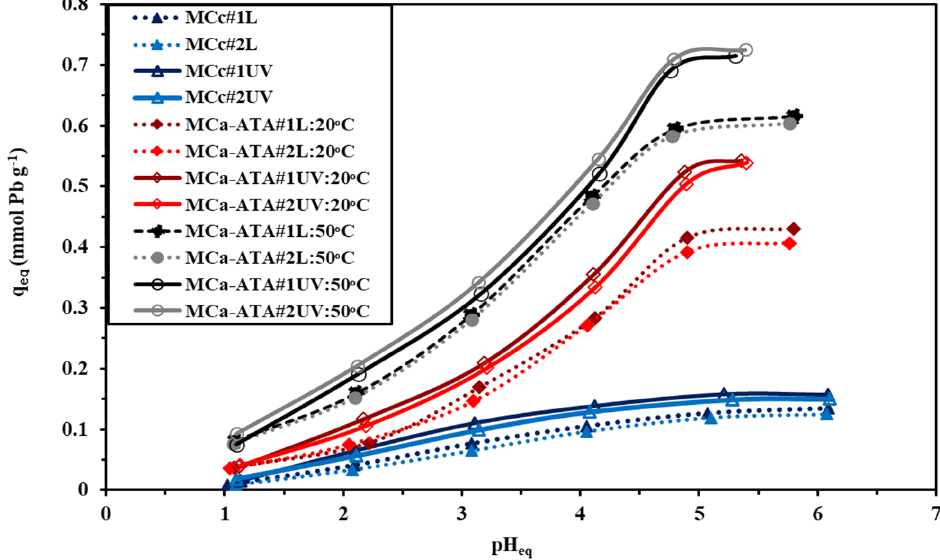
Figure 5. Effect of pH on the sorption performances under visible light (L) and UV for MCc and MCa-ATA sorbents . MCa-ATA